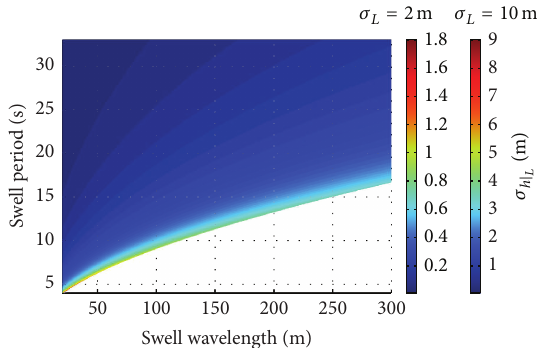
Figure 6: Uncertainty in the estimated water depth due to that in swell wavelength in the considered admissible (𝐿,𝑇) area for 𝜎 𝐿 = 2 m and 𝜎 𝐿 = 10m. (continuous limit